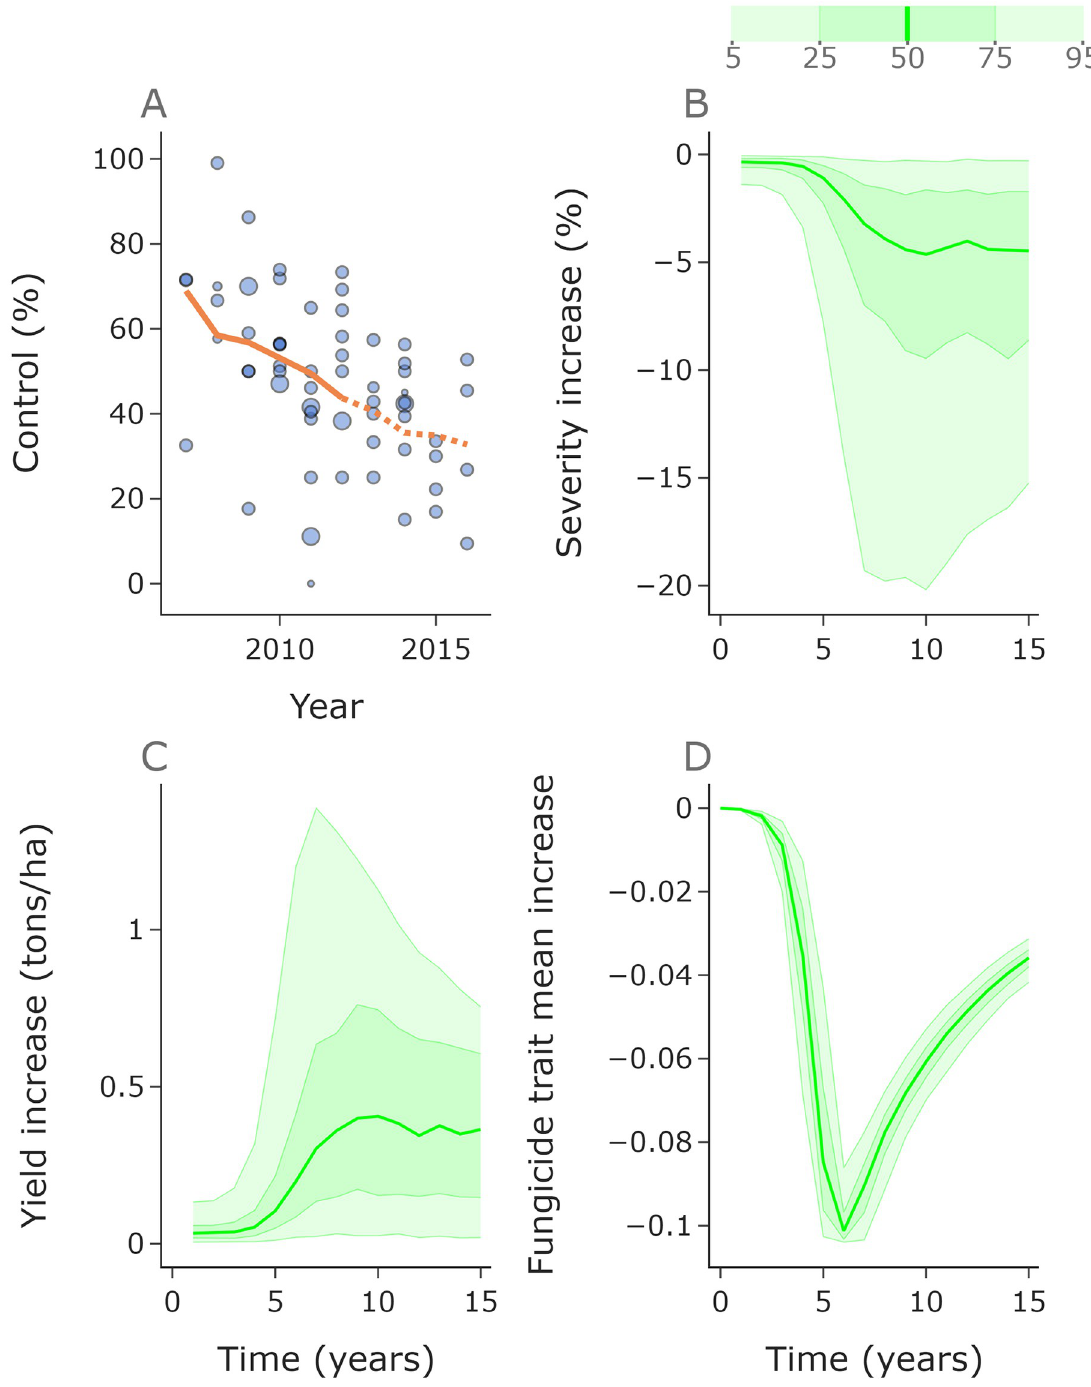
Fig 5. Disease-resistant cultivars reduce severity and protect the fungicide. The optimal host trait initial distribution parameters were fitted using data from 2007 to 2012 (solid line, A ). We used data from 2013 to 2016 as a test set (dotted line). When comparing a two application fungicide programme with and without the disease-resistant cultivar, the disease-resistant cultivar reduces the severity ( B ) and increases yield ( C ); in each case the response shown is the difference between two spray fungicide programmes with and without the resistant cultivar. Further, the fungicide develops resistance more slowly due to reduced disease pressure when the resistant cultivar is used ( D ). This means the benefit of using the resistant cultivar becomes greater as time goes on, and is particularly noticeable in high disease pressure years with yield improvements of up to 1.39 tons/ha in the 95th percentile in year 7. Here n